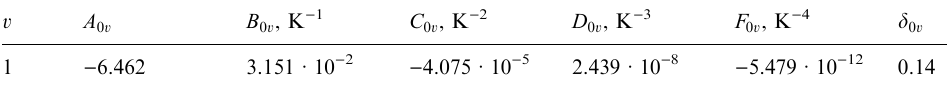
Table 2. Coe(cid:129)cients for calcu- lations of Q 0 v for 300 (cid:20) T e (cid:20) 1500 K